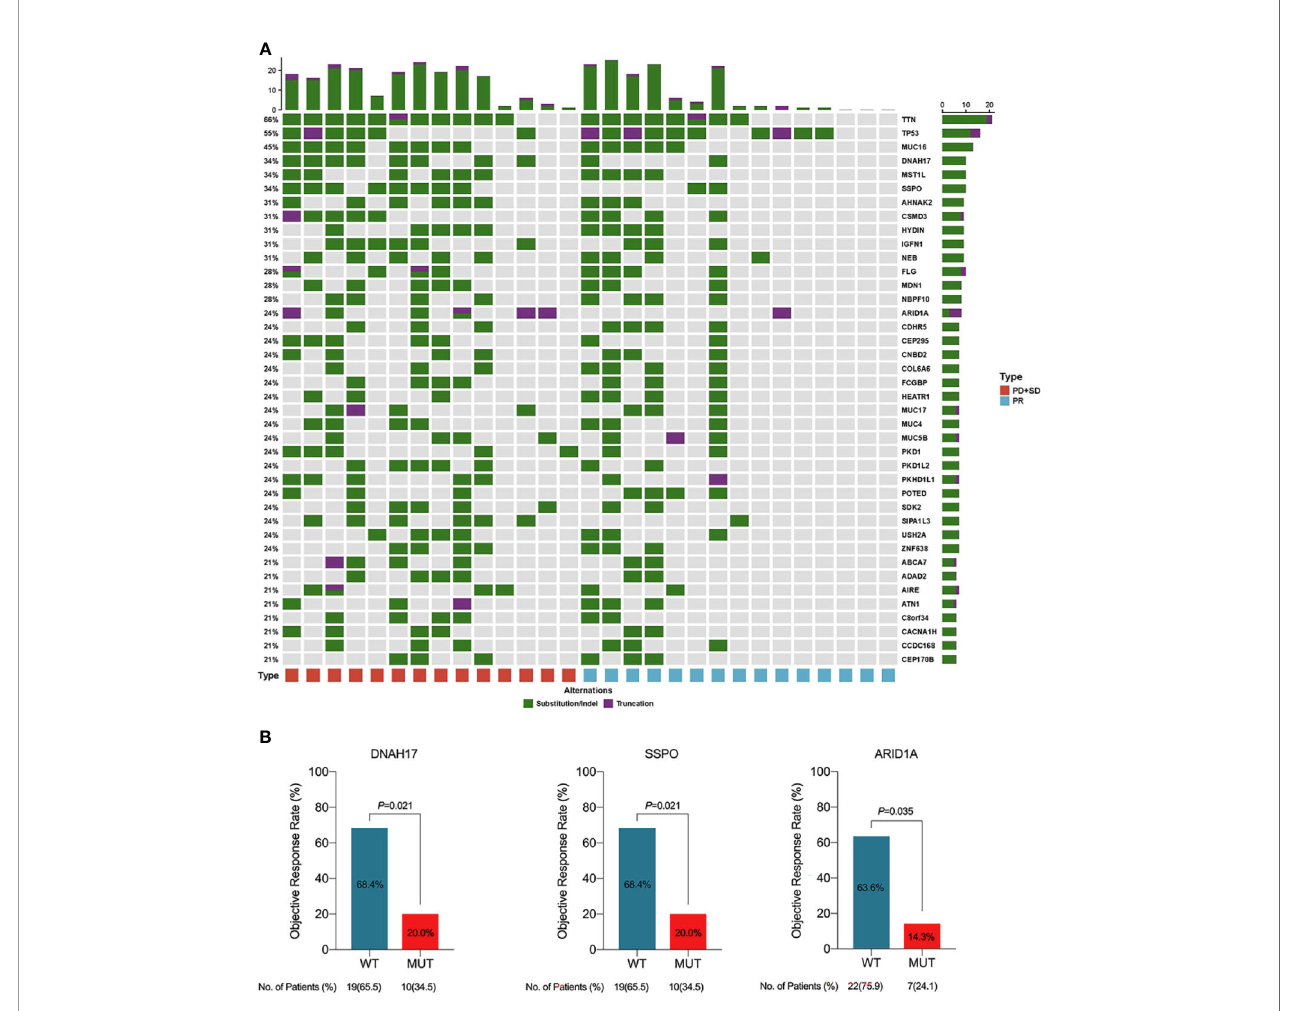
FIGURE 6 | (A) Genetic alternations and frequencies identi fi ed by whole exome sequencing (WES) from 29 available patients. (B) Clinical response in relation to gene mutations in patients with initial unresectable BTC. PD, progressive disease; PR, partial response; SD, stable disease; WT, wide type; MUT,